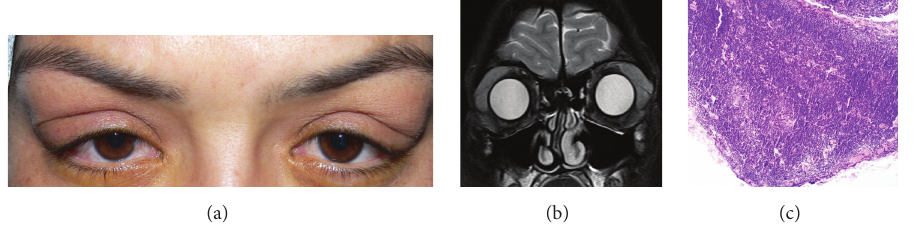
Figure 1: (a) Bilateral puffiness in lacrimal gland region is evident. (b) On MRI bilateral hypertrophic lacrimal glands are seen. (c) Histopathologic examination revealed neoplastic infiltration of small to medium sized lymphoid cells forming a vaguely nodular pattern (H&E, × 10).